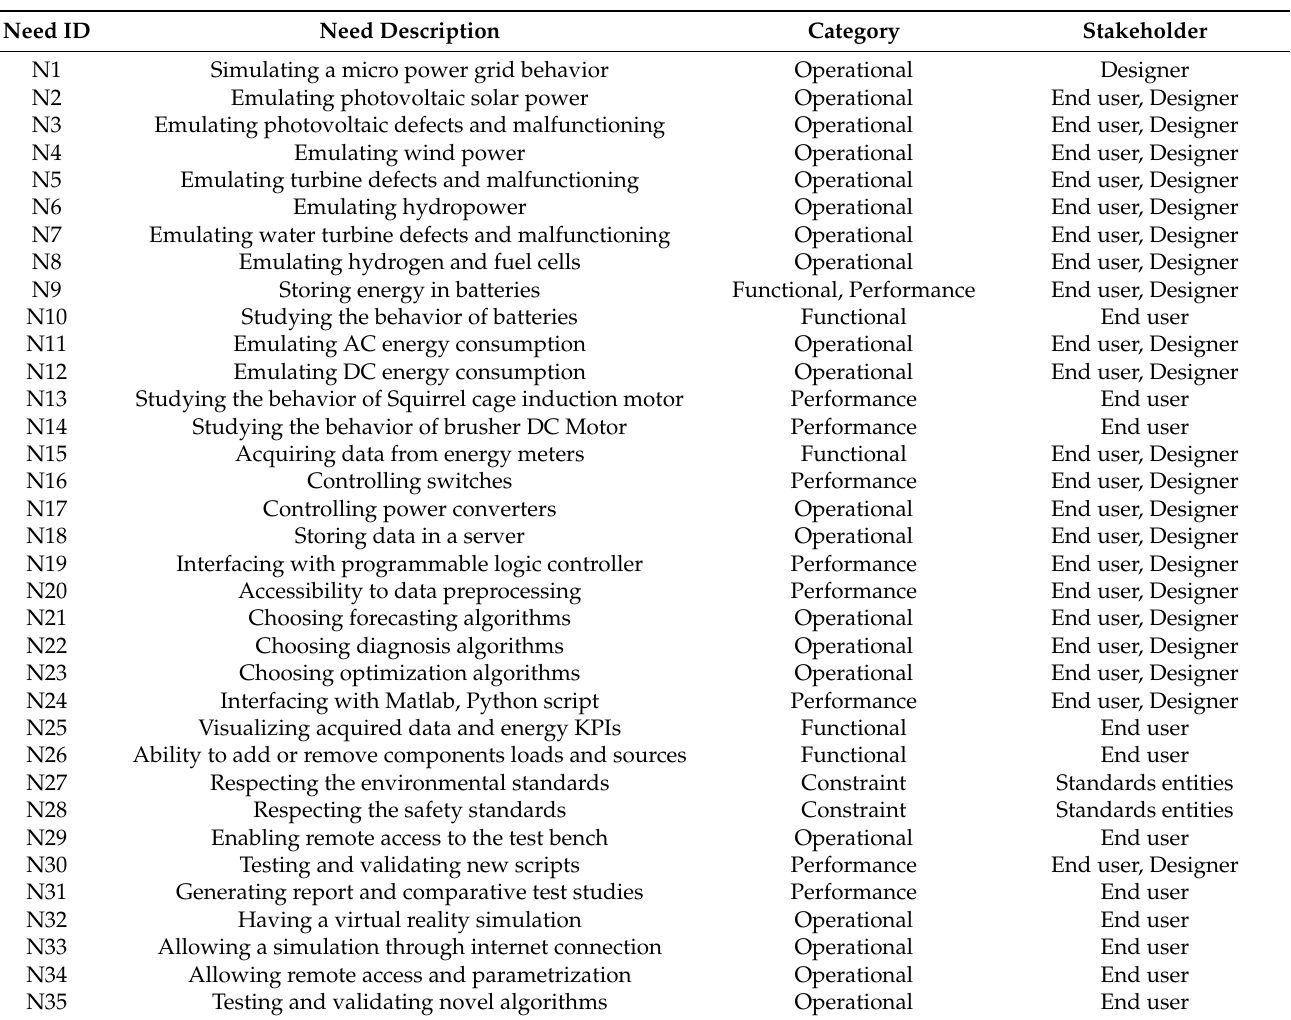
Table 1. Classification of the stakeholders’